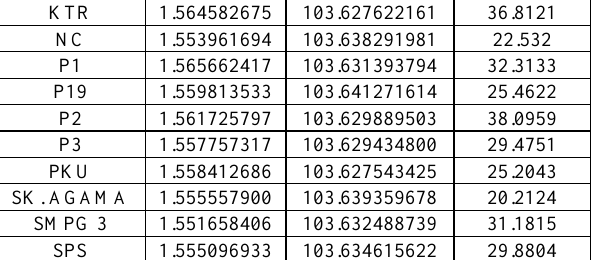
Table 4. Coordinates and ellipsoidal height for each BM